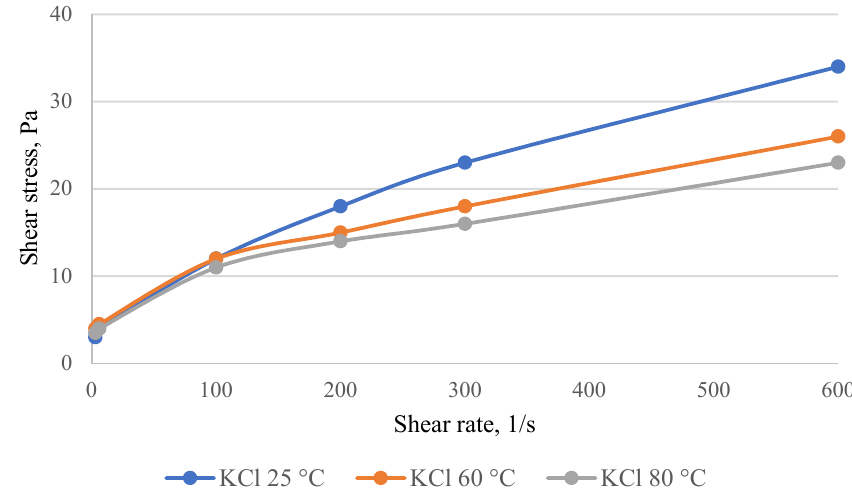
Figure 2. Rheological curves of KCl-based mud at different temperatures.